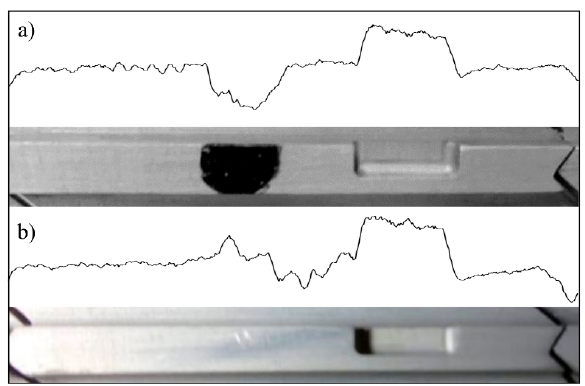
Figure 8. Waveform signals corresponding to OS 3 in two different cases: ( a ) a blade with a black-painted area on it. ( b ) A blade with variable reflectivity along it.